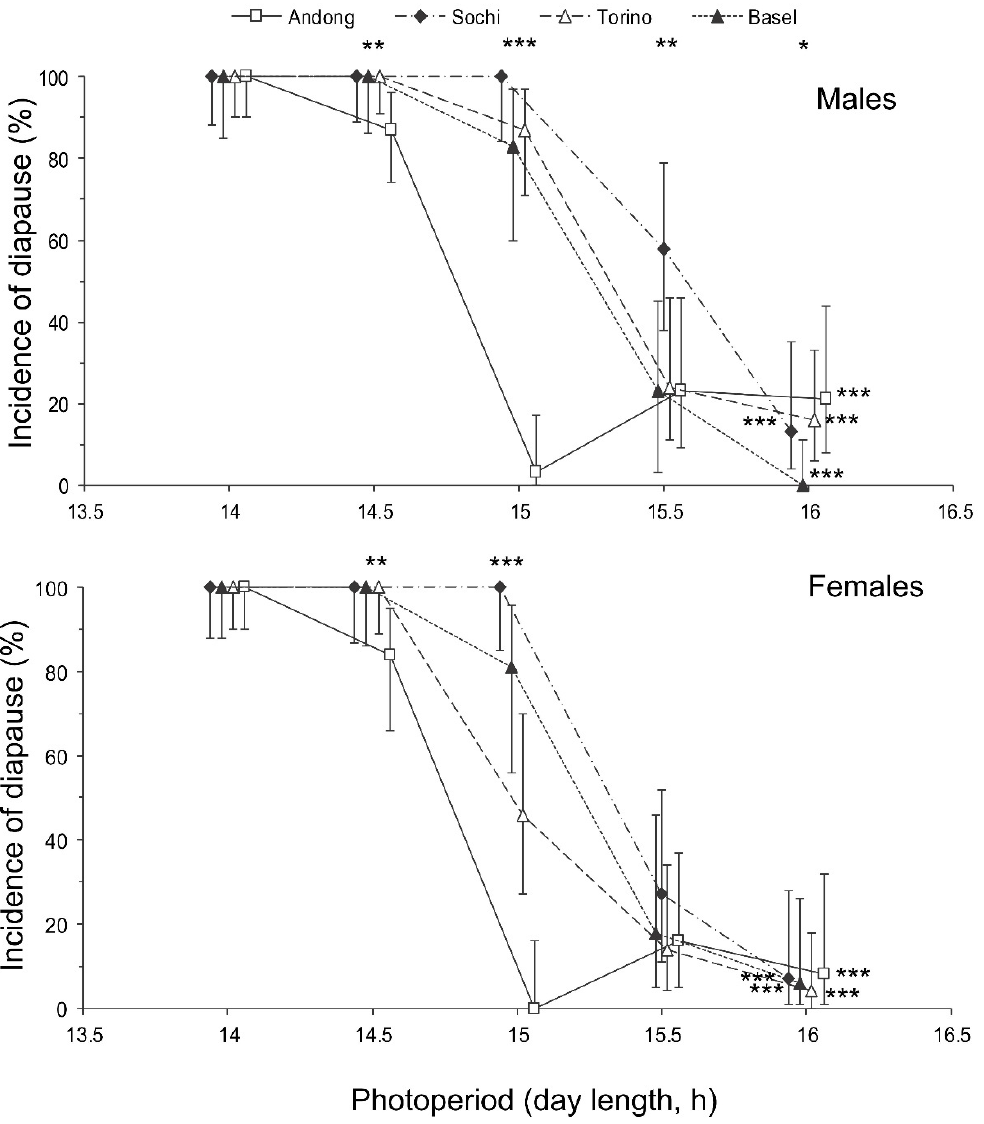
Figure 4. Effect of day length on the incidence of diapause in Halyomorpha halys males and females from different populations at 24 ◦ C. Percentage and 95% confidence intervals are shown ( n = 21–48 per treatment). Asterisks at the right end of the graphs indicate a significant difference between the data for individuals of the same population reared under different photoperiods, i.e., the significant photoperiodic response. Asterisks above the graphs indicate a significant difference between the data for individuals from different populations reared under the same photoperiod, i.e., significant interpopulation variation (* − p < 0.05, ** − p < 0.01, *** − p < 0.001 by the Chi-square test). Some symbols are slightly shifted horizontally to avoid